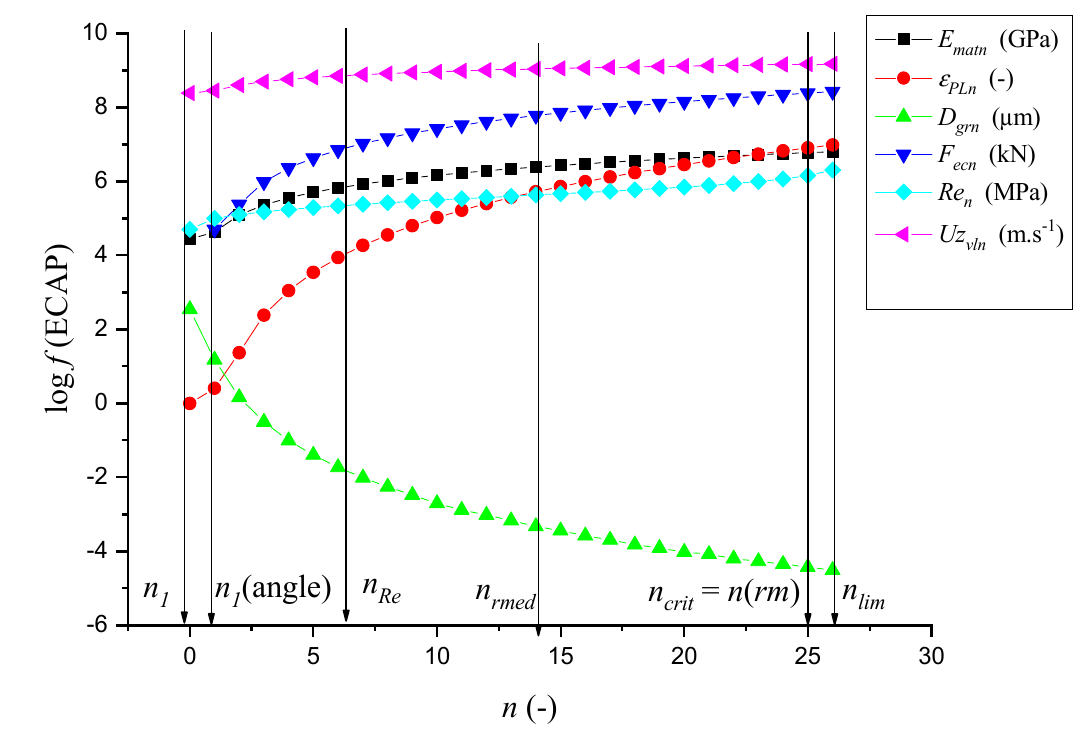
Figure 5. Results from Tables 1 and 2 in logarithmic measure.